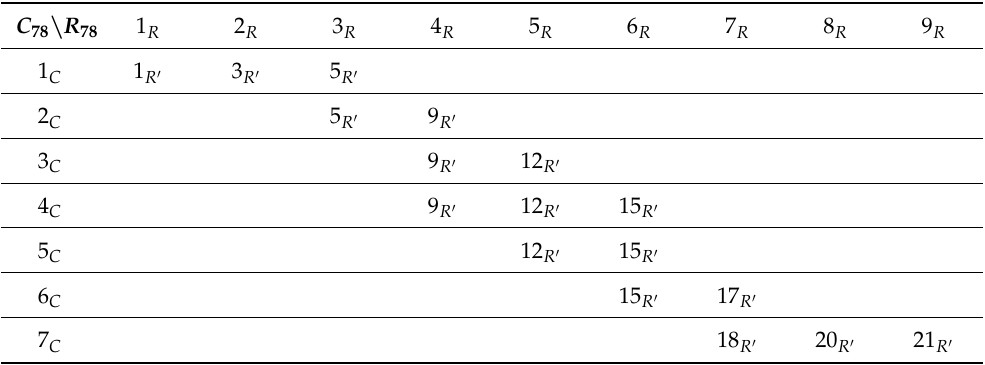
Table 10. Fuzzy rules designed for strong failure correlation Machine pair